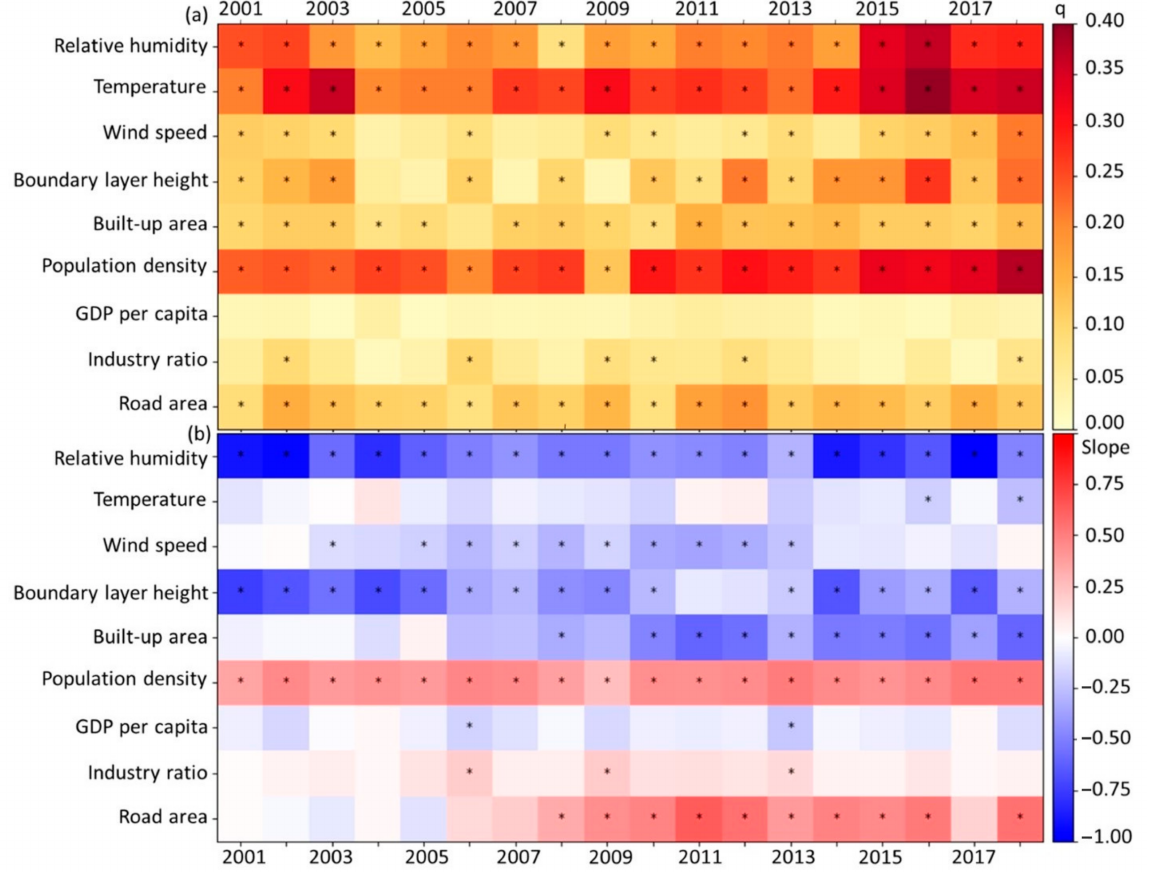
Figure 5. ( a ) Power of determinant value q and ( b ) standardized slope of a linear model for each impact factor from 2001 to 2018 in eastern China. Asterisk (*) in a square indicates it is statistically significant at a p -value of